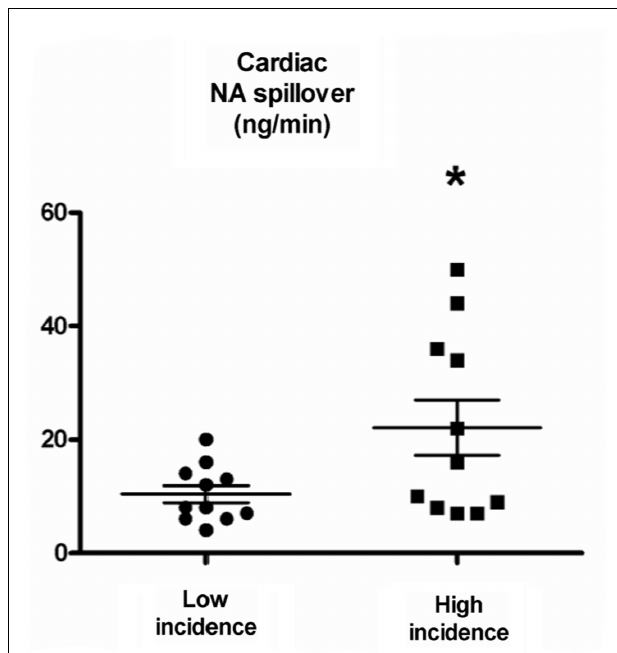
FIGURE 2 | Cardiac noradrenaline (NA) spillover in subjects with low and high incidence of multiple spikes. In all subjects combined, the median value of the incidence of multiple spikes per was 9%. Low incidence of multiple spikes was defined as < 9% and high incidence was > 9%. From Lambert et al.